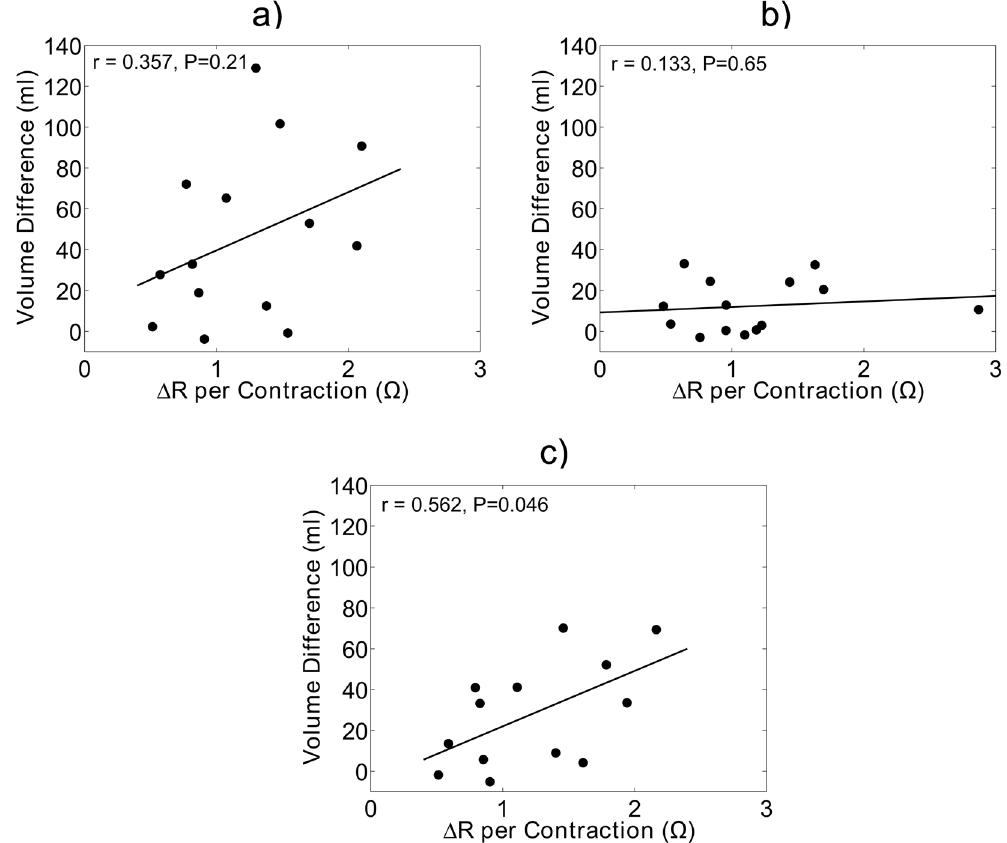
Figure 5. Scatterplots illustrating correlations between final volume differences and the change in resistance per contraction ( Δ R per contraction) for: ( a ) all study data ( b ) the first 20 minutes seated and ( c ) the latter 130 minutes seated. Correlations are assessed by either Pearson’s correlation coefficient or Spearman’s rho depending on normality of the data distribution as assessed by the Shapiro-Wilk test of